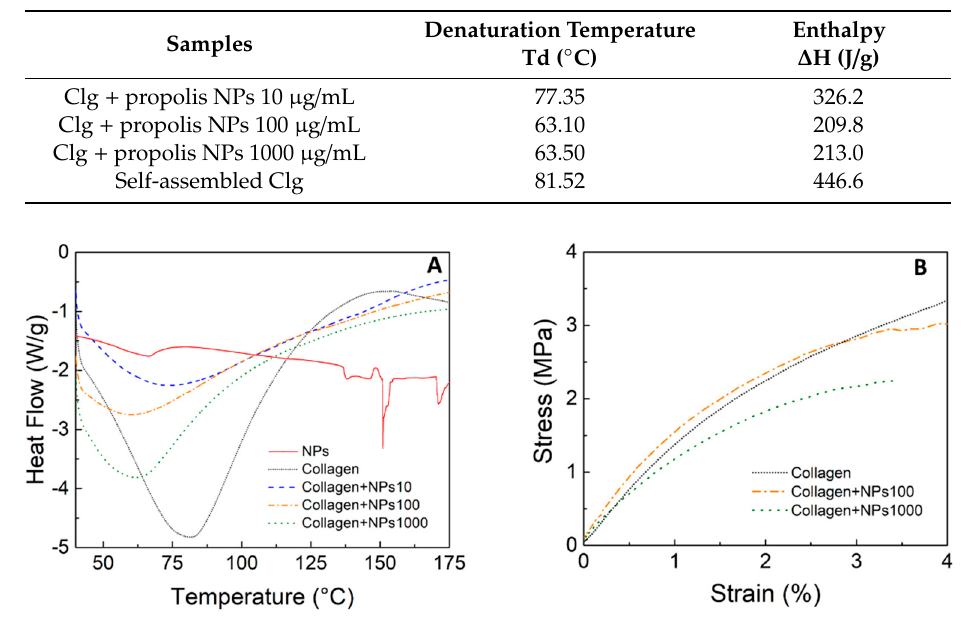
Figure 5. ( A ) DSC curves for type I collagen, propolis NPs, and collagen impregnated with propolis nanoparticles at different concentrations. ( B ) Stress–strain diagram of collagen impregnated with propolis nanoparticles at different concentrations.